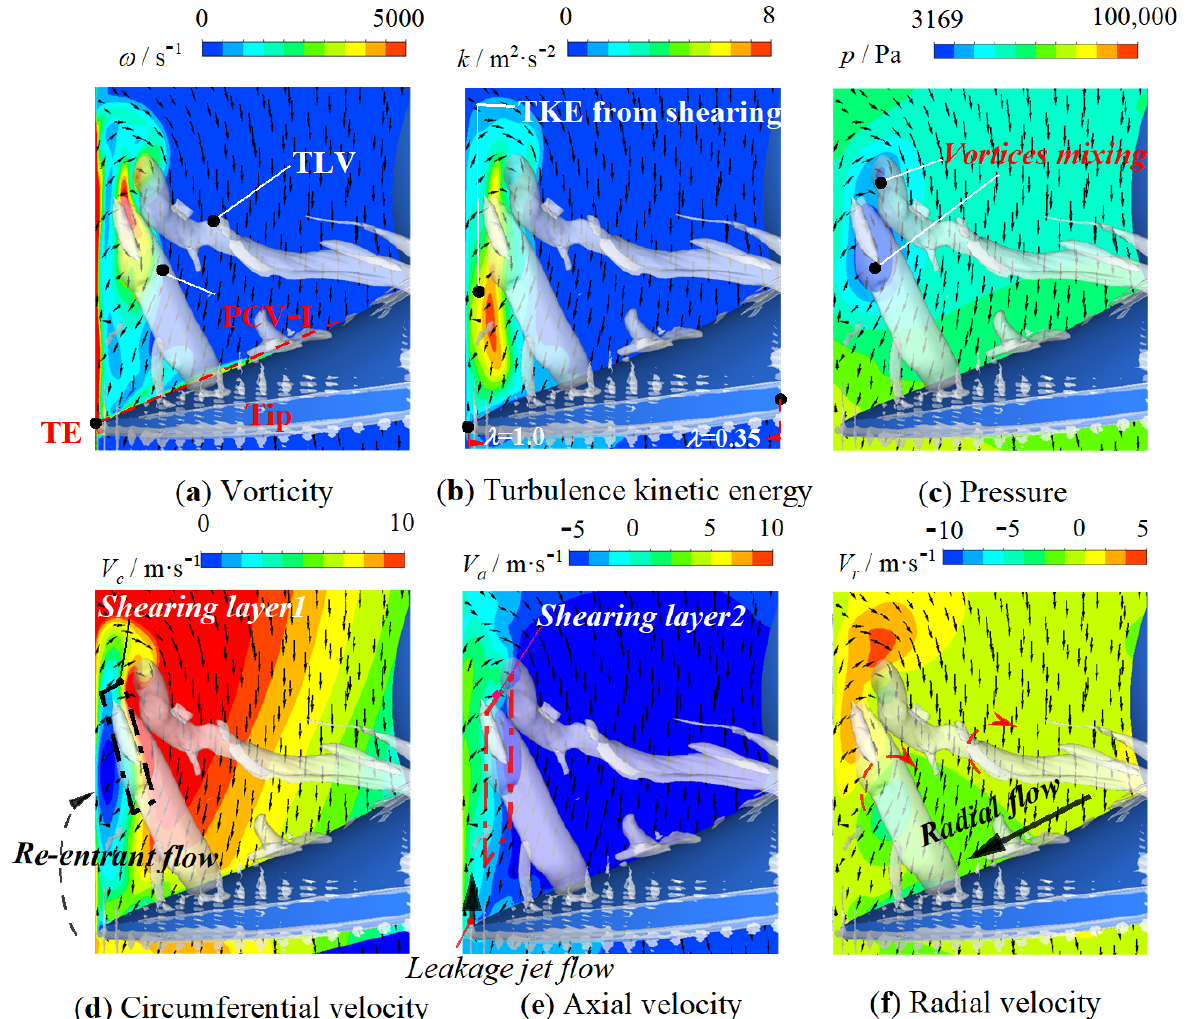
Figure 15. Distribution of plane physical quantities in the stage of vortex generation at t = t 0 + 3T/30 (swirling strength isosurface Sw = 1000 s − 1 (white), Q = 0.8 Q BEP , σ = 0.35).